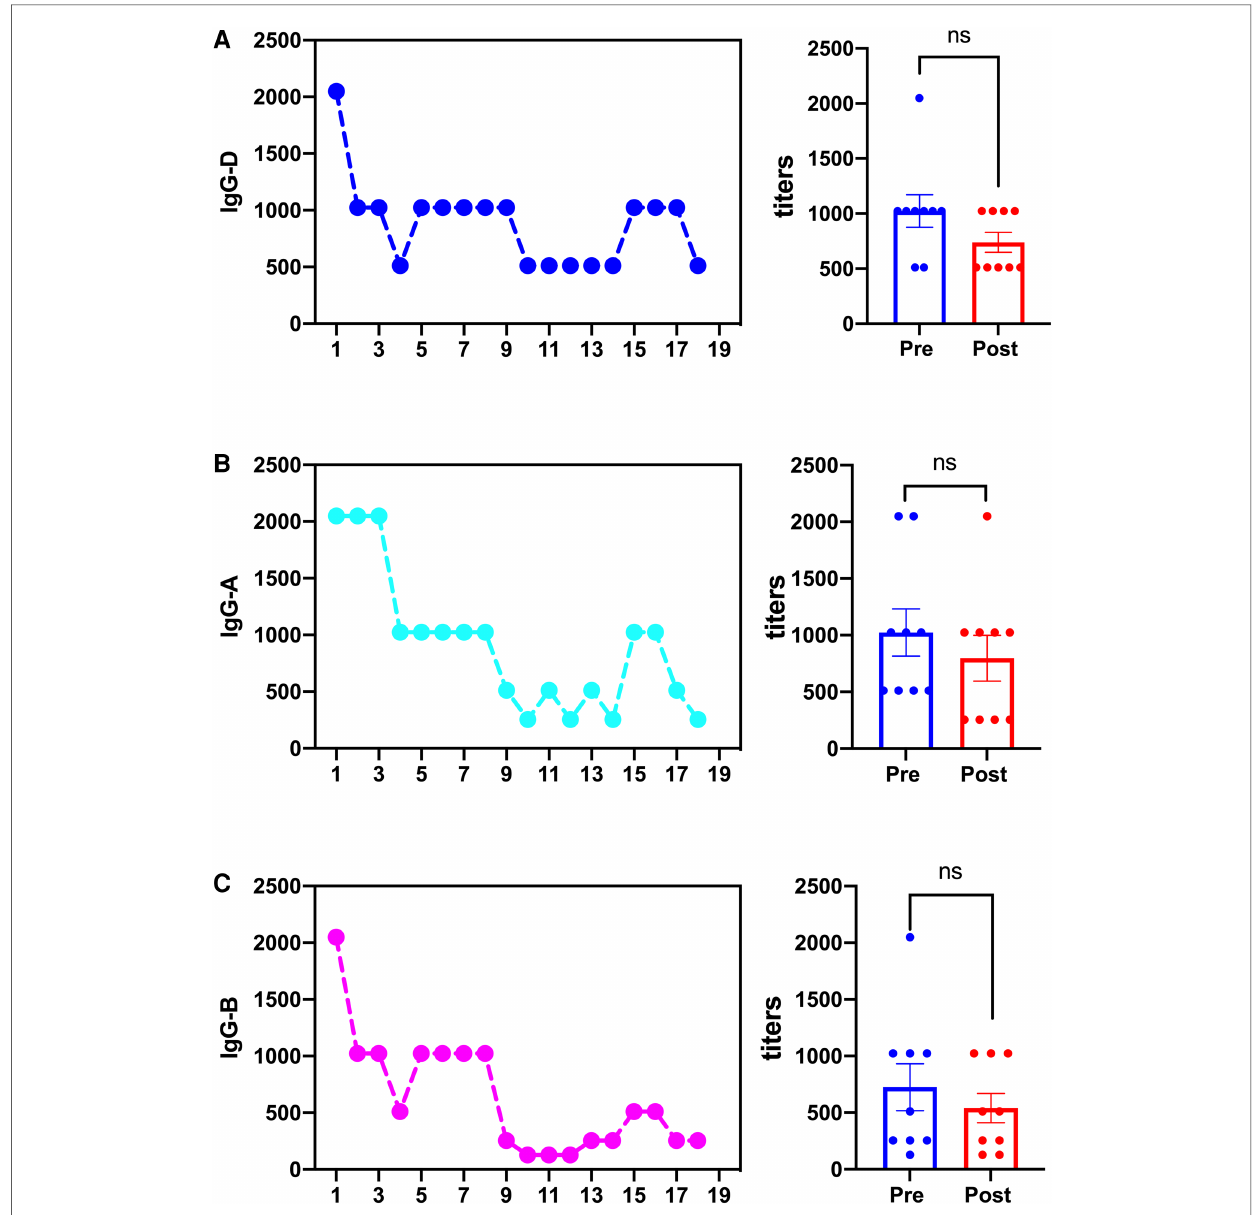
FIGURE 2 The changes of IgG-D, ( A ), and ( B ) antibodies during DFPP treatment (case 1). ( A ) The change of IgG-D titers and the comparison of IgG-D titers pre- and post- DFPP treatment. ( B ) The change of IgG-A titers and the comparison of IgG-A titers pre- and post- DFPP treatment. ( C ) The change of IgG-B titers and the comparison of IgG-B titers pre- and post- DFPP treatment. odd numbers represent pre-DFPP. ns, not signi fi